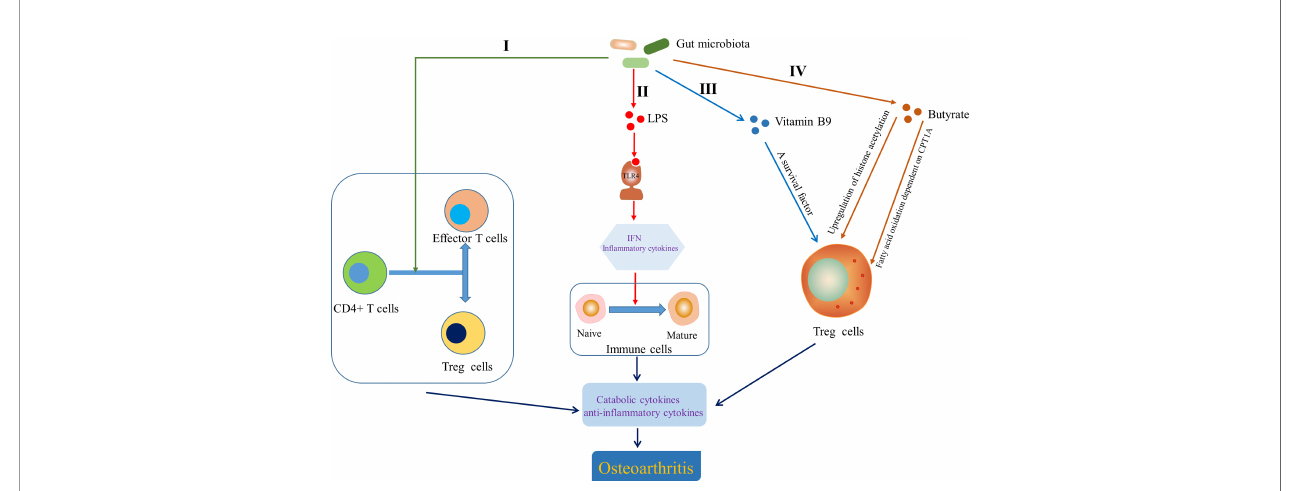
FIGURE 5 | Effect of gut microbiota on the adaptive immunity. I Gut microbiota determined the direction of differentiation of primitive CD4+ T cells into effector T cells or Treg cells (Honda and Littman, 2012). II Lipopolysaccharide (LPS) helped to induce naive immune cells to mature immune cells by activating Toll-like receptor 4 (TLR4) to cause an in fl ammatory cascade (Chen et al., 2011; Chu and Mazmanian, 2013; Kim, 2013). III Vitamin B9 contributed to the survival of Treg cells (Kunisawa et al., 2012). IV Butyrate modulated the generation and differentiation of Treg cells by up regulating histone acetylation (Arpaia et al., 2015) and enhancing fatty acid oxidation dependent on carnitine palmitoyl transferase 1A (CPT1A) (Hao et al., 2021). IFN,